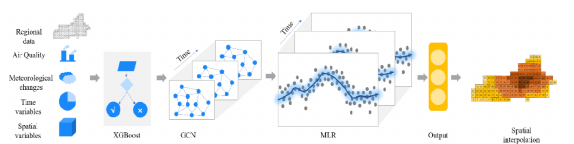
Figure 2. VOCs aggregation intelligent sensing model